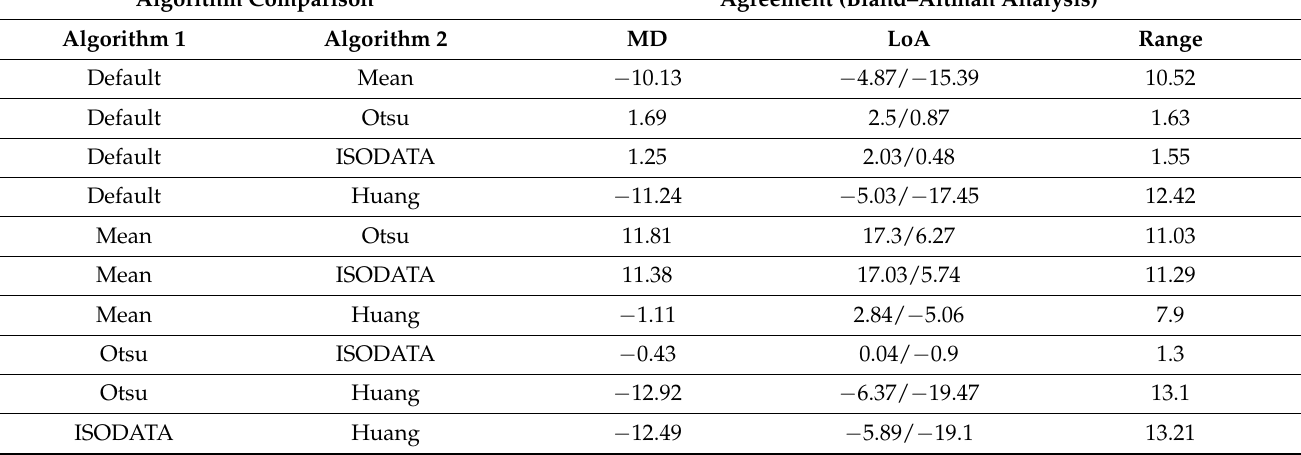
Table 4. Bland–Altman analysis for inter-algorithm agreement in the full retina slabs for the entire study